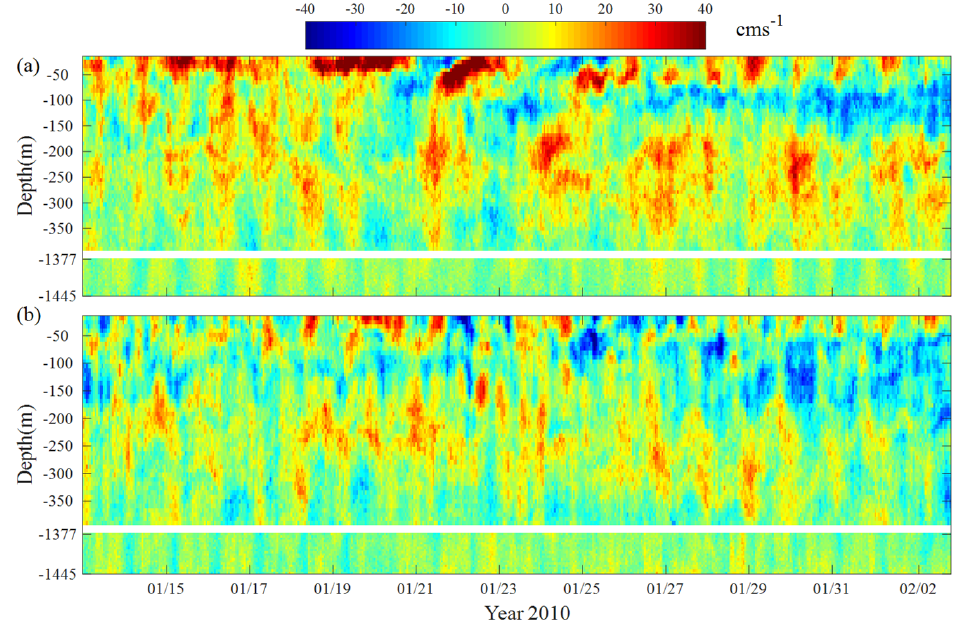
Figure 2. Depth-time maps of raw currents in the eastward ( a ) and northward ( b ) directions in January 2010.